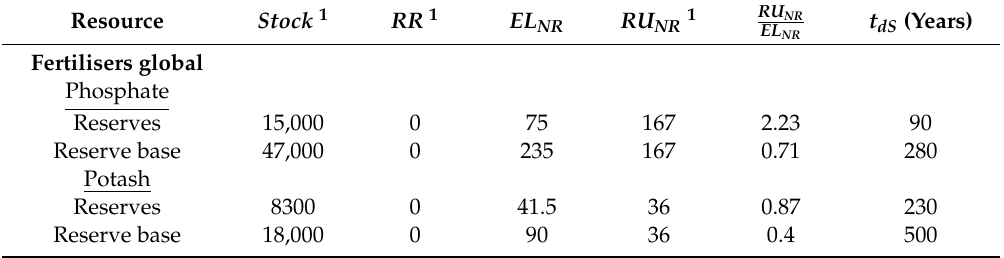
Table 4. Environmental sustainability assessment of phosphate and potash resources [ t S = 200